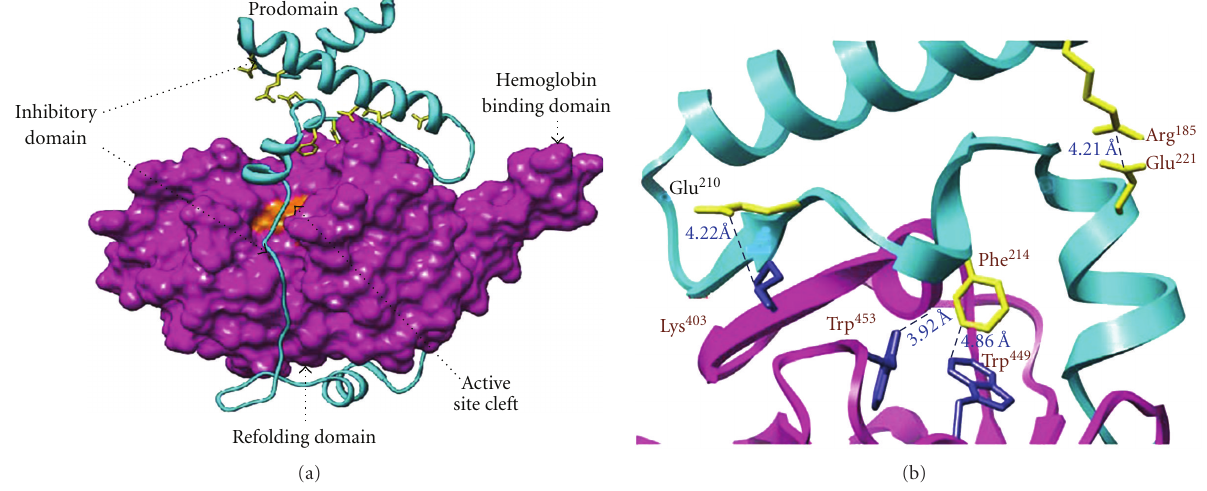
Figure 4: (a) Structure of profalcipain-2: The mature domain (magenta) of falcipain-2 was solved by X-ray di ff raction. The active site (catalytic triad residues in orange), refolding domain, and hemoglobin domain are labeled [25]. The prodomain (cyan) modeling was done based on procathepsin L and K [24]. The prodomain runs up the face of the mature enzyme (purple) before forming α helices containing the conserved ERFNIN and GNFD motifs (yellow). Since there is no homology, the 160 N-terminal residues of the prodomain are not included in the prodomain model. (b) Prodomain-mature domain interactions. Closeup of predicted interactions between the mature domain (magenta) and the ERFNIN (R 185 ) and GNFD (E 210 ; F 214 ) motifs of prodomain (cyan). Blue dashed lines indicate presumed stabilizing interactions (both electrostatic as well as hydrophobic) between residues